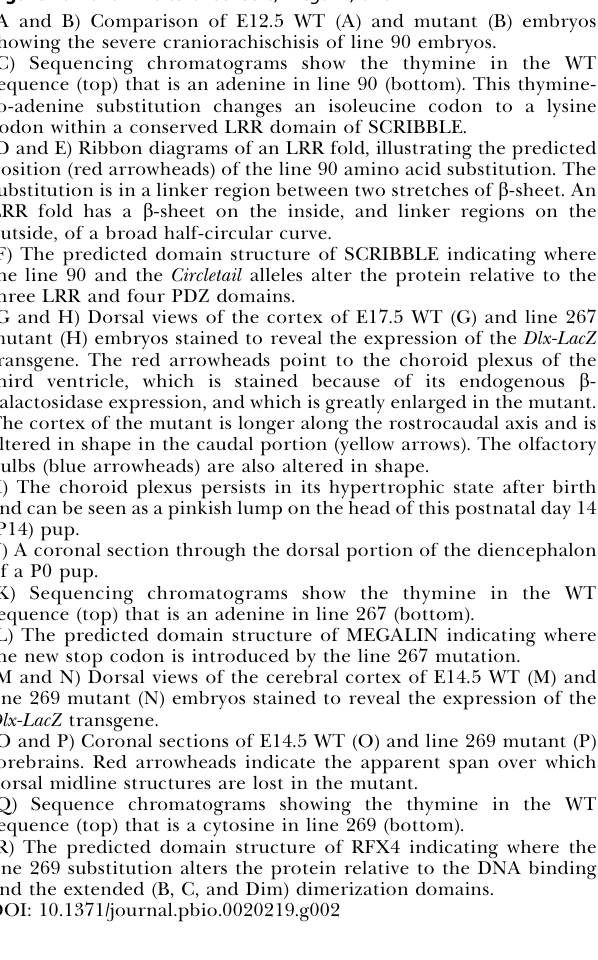
Figure 2. Novel Alleles of scribble, megalin, and Rfx4 (A and B) Comparison of E12.5 WT (A) and mutant (B) embryos showing the severe craniorachischisis of line 90 embryos. (C) Sequencing chromatograms show the thymine in the WT sequence (top) that is an adenine in line 90 (bottom). This thymine- to-adenine substitution changes an isoleucine codon to a lysine codon within a conserved LRR domain of SCRIBBLE. (D and E) Ribbon diagrams of an LRR fold, illustrating the predicted position (red arrowheads) of the line 90 amino acid substitution. The substitution is in a linker region between two stretches of b -sheet. An LRR fold has a b -sheet on the inside, and linker regions on the outside, of a broad half-circular curve. (F) The predicted domain structure of SCRIBBLE indicating where the line 90 and the Circletail alleles alter the protein relative to the three LRR and four PDZ domains. (G and H) Dorsal views of the cortex of E17.5 WT (G) and line 267 mutant (H) embryos stained to reveal the expression of the Dlx-LacZ transgene. The red arrowheads point to the choroid plexus of the third ventricle, which is stained because of its endogenous b - galactosidase expression, and which is greatly enlarged in the mutant. The cortex of the mutant is longer along the rostrocaudal axis and is altered in shape in the caudal portion (yellow arrows). The olfactory bulbs (blue arrowheads) are also altered in shape. (I) The choroid plexus persists in its hypertrophic state after birth and can be seen as a pinkish lump on the head of this postnatal day 14 (P14) pup. (J) A coronal section through the dorsal portion of the diencephalon of a P0 pup. (K) Sequencing chromatograms show the thymine in the WT sequence (top) that is an adenine in line 267 (bottom). (L) The predicted domain structure of MEGALIN indicating where the new stop codon is introduced by the line 267 mutation. (M and N) Dorsal views of the cerebral cortex of E14.5 WT (M) and line 269 mutant (N) embryos stained to reveal the expression of the Dlx-LacZ transgene. (O and P) Coronal sections of E14.5 WT (O) and line 269 mutant (P) forebrains. Red arrowheads indicate the apparent span over which dorsal midline structures are lost in the mutant. (Q) Sequence chromatograms showing the thymine in the WT sequence (top) that is a cytosine in line 269 (bottom). (R) The predicted domain structure of RFX4 indicating where the line 269 substitution alters the protein relative to the DNA binding and the extended (B, C, and Dim) dimerization domains. DOI: the Circletail allele, a strong genetic interaction was seen between the line 90 allele of Scrb1 and the Ltap/Lpp1 mutation, such that embryos indistinguishable from homozygotes of the individual mutations were recovered (unpublished data). This indicates quite clearly that the integrity of the LRR domains is critical for the tight coordination between Scrb1 and Ltap/ Lpp1 in establishment of planar cell polarity.